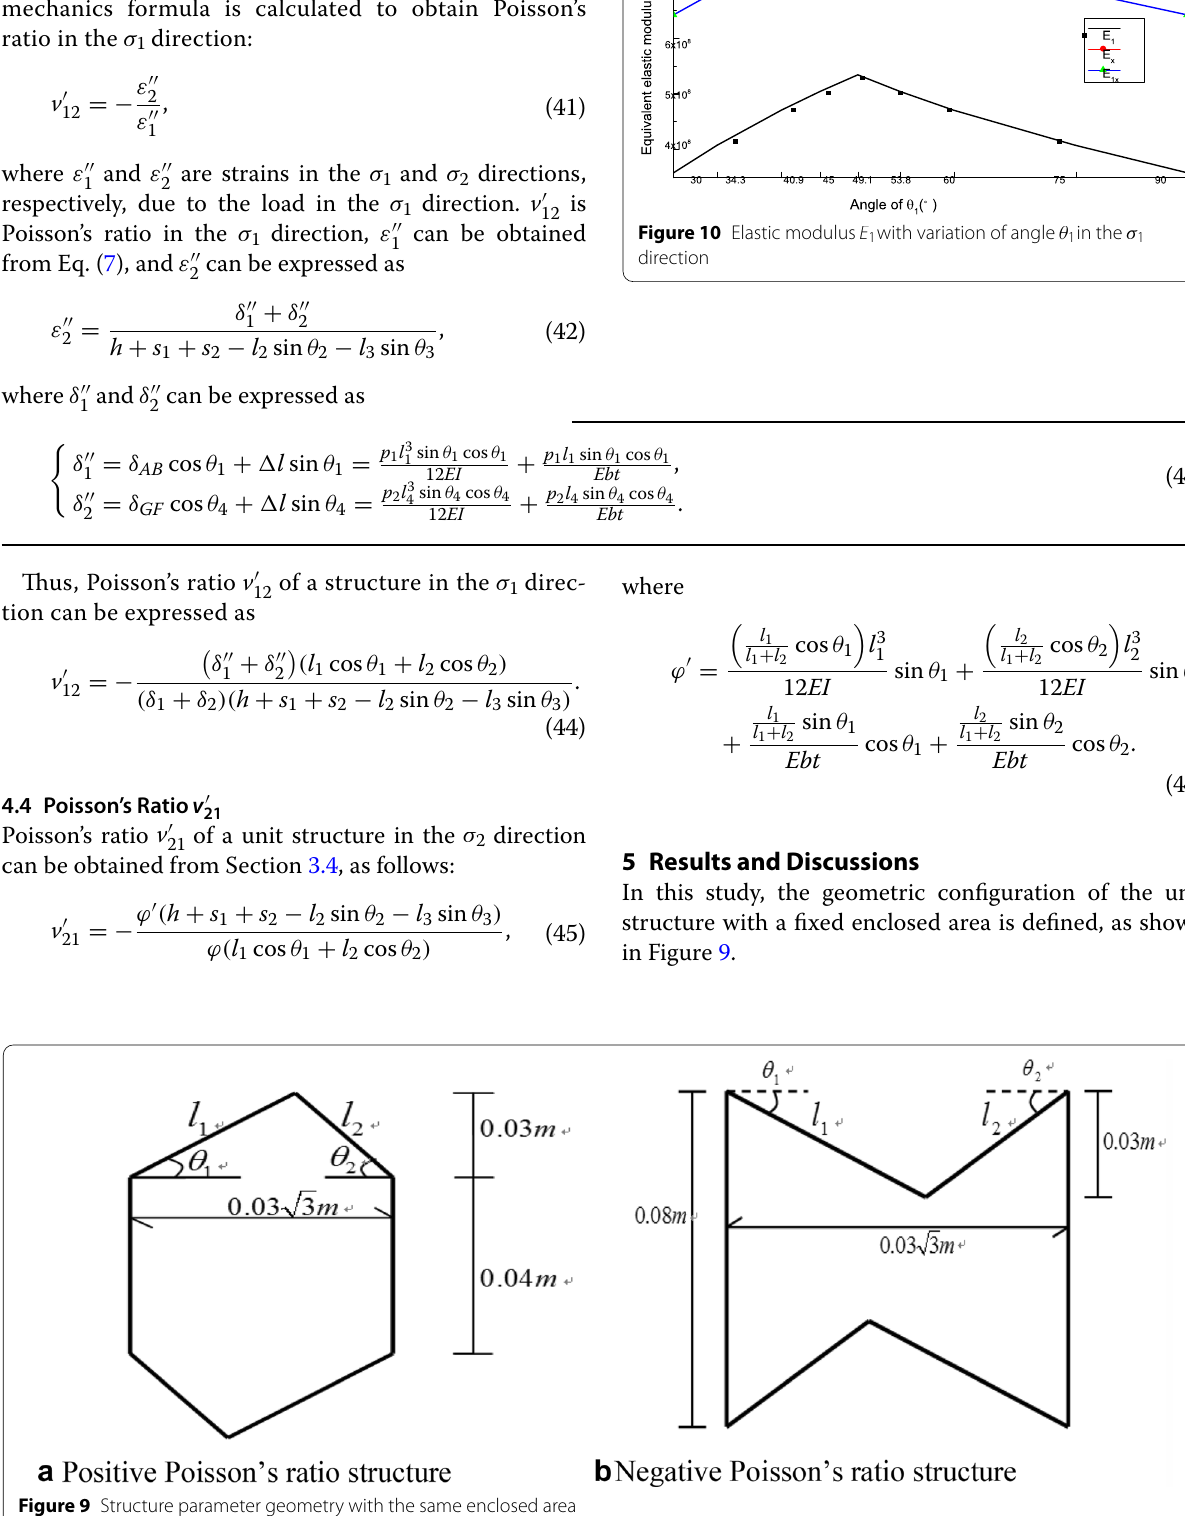
Figure 9 Structure parameter geometry with the same enclosed area